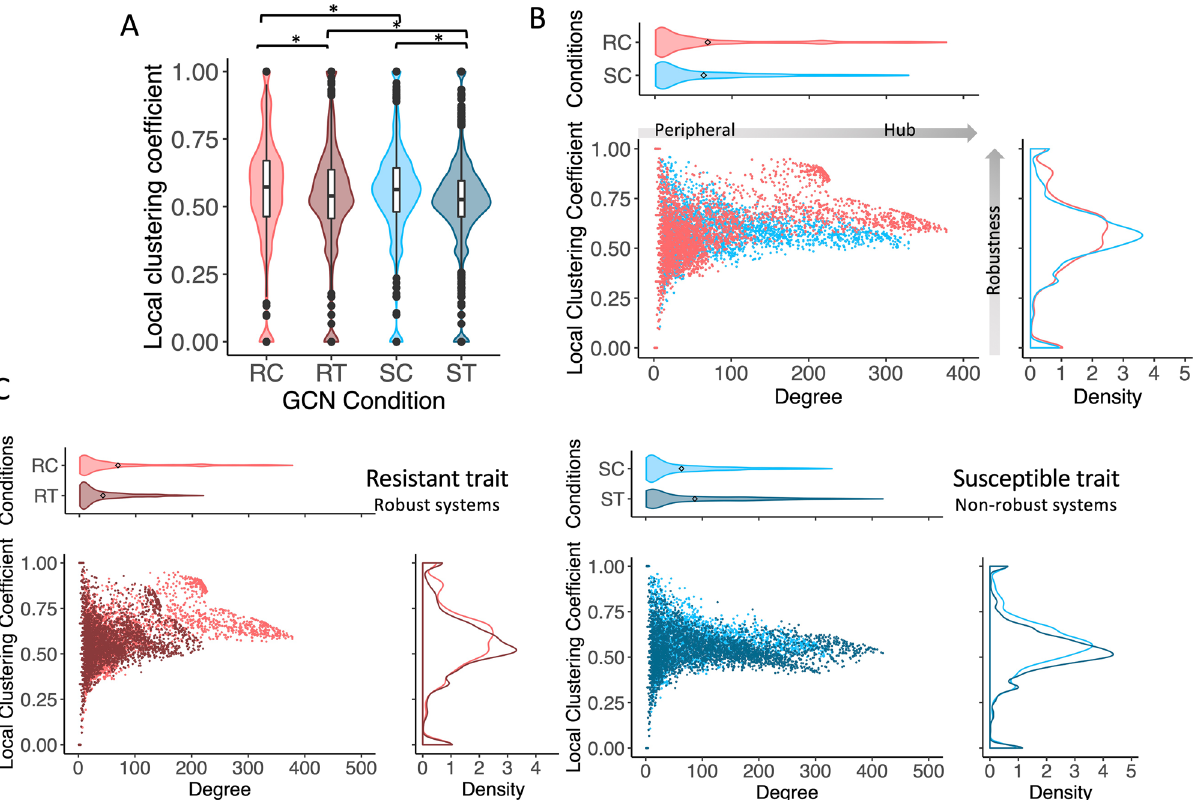
Figure 1. Local network properties of condition-specific GCNs; ( A ) Violin plots showing the distribution of the local clustering coefficient for all four GCNs. Asterisks (*) indicate statistically significant differences based on the Wilcoxon rank-sum one-sided test ( p -value < 0.05). For inter-trait comparison, the median local clustering coefficients for the resistant trait were higher in both control and treatment conditions (GCN-RC > GCN-SC; GCN-RT > GCN-ST). For intra-trait comparison, the median local clustering coefficient was higher in control conditions across traits (GCN-RC > GCN-RT; GCN-SC > GCN-ST). ( B ) Scatter plot showing the distribution of local properties of nodes in GCNs under control conditions (GCN-RC and GCN-SC), and ( C ) in response to the viral infection (GCN-RT and GCN-ST). The resistant trait (C-left) responded to perturbation by dramatically decreasing the high degree nodes (hubs) and slightly decreasing the local clustering coefficient, while the susceptible trait (C-right) increased hubs and decreased the clustering coefficient in response to perturbation. The x-axis in scatter and violin plots represents the node degree, and the y-axis in scatter and density plots represents the local clustering coefficient. High-degree nodes or hub genes represent gene regulatory hubs, whereas high clustering coefficients denote highly collaborative gene association and network cassava variety ( d SC = 28 and e/n SC = 30.0; d ST = 24 and e/n ST = 42.1) and increased diameter with less connections for the resistant cassava variety ( d RC = 23 and e/n RC = 32.6; d RT = 26 and e/n RT = 19.7). Correspondingly, Fig. 1C showed an inverse change in the clustered network topology of GCNs against CBSV infection between the two varieties. GCN-RT shows a reduction in the degree of gene cooperation with a little change in the clustering topology, whereas GCN-ST shows an increase in degree of gene cooperation with a superior impact on the clustering topology (Fig. 1C and Additional Information 1C,D), suggesting an antagonistic regulatory response to CBSV infection in both varieties. Based on the analysis, we propose that network topology is central to the robustness of biological systems. GCNs require not only scale-free and small-world macroscopic properties but also high clustering of individual constituents. The conceptual schemes of generalized regulatory networks were proposed accordingly for resistant (Fig. 2A, left) and susceptible (Fig. 2A, right) characteristic traits. The network topology of the resistant system contains abundantly clustered motifs that are well connected, while that of the susceptible system contains clus- ters that are sparsely linked to each other. The hypothetical network structures are supposed to describe gene cooperative patterns of both susceptible (GCN-S) and resistant (GCN-R) varieties in response to CBSV infection. Although the infection disrupted the high degree nodes in GCN-R, leading to a decrease in the clustering coef- ficient, the neighboring genes were able to cooperate and maintain essential functions. The GCN-S responded to the infection by promoting the interconnection of genes (edge); nonetheless, it could not achieve robust gene cooperation as indicated by the severe symptoms observed. These hypothetical models were tested in an in silico perturbation experiment, during which the loss of gene (node) interconnections, measured in terms of mean variance information (VI), was determined for each edge removal in a sequence until complete numbers. As